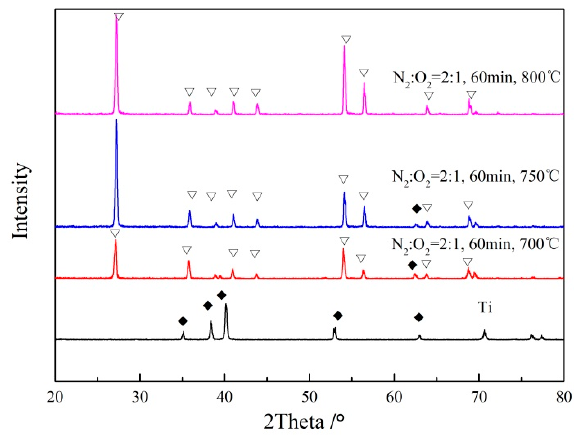
Figure 8. XRD pattern of the Ti support after oxidation under N 2 :O 2 = 2:1, for 60 min at different temperatures.